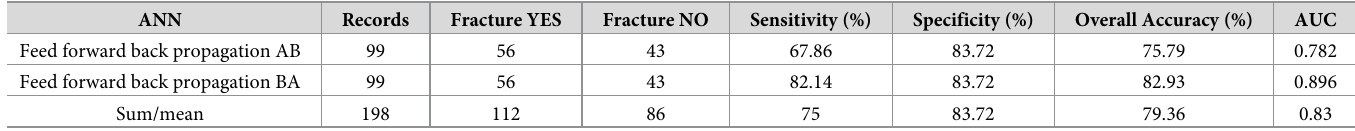
Table 3. Predictive results using artificial intelligence systems. The results refer to two testing experiments with training-testing A-B and B-A sequence. ANN